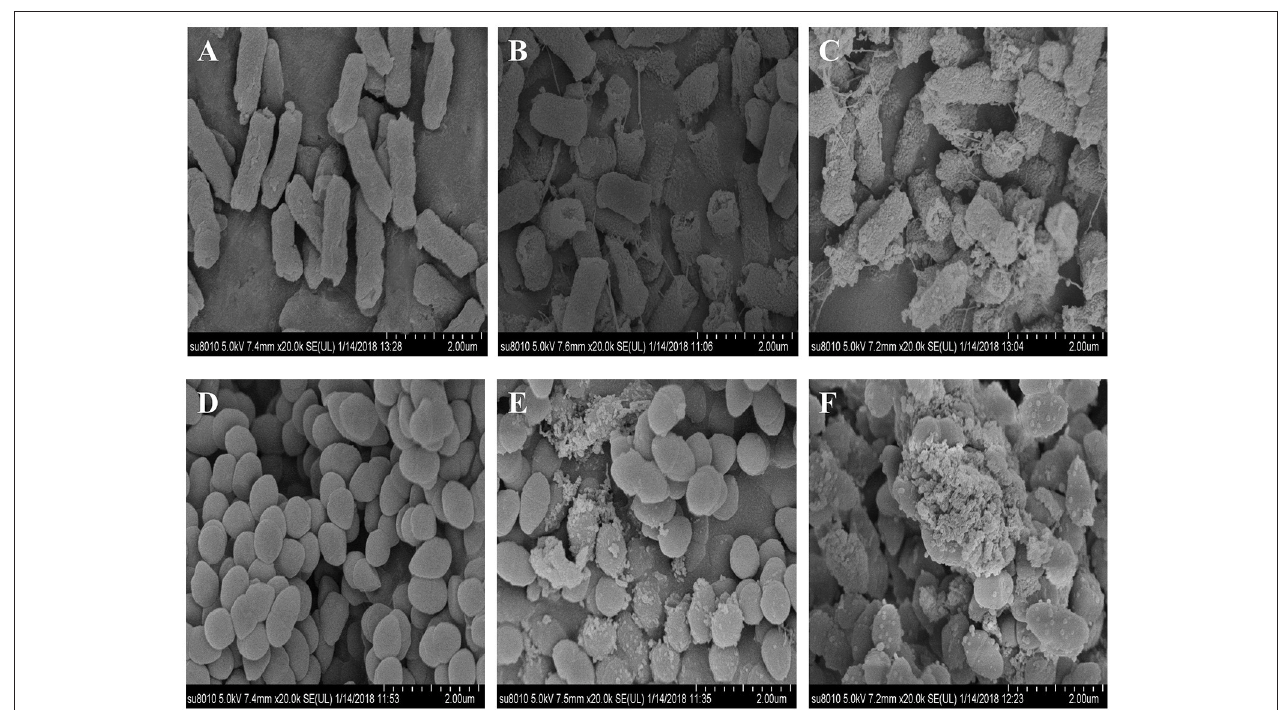
FIGURE 5 | SEM micrographs of E. coli and S. xylosus untreated (A,D) , treated with 10 mg/mL CD-g-CS (Q CD = 0.643 × 10 3 µ mol/g) (B,E) , and treated with 10 mg/mL CD-g-CS (Q CD = 0.6 × 10 2 µ mol/g) (C,F) ,